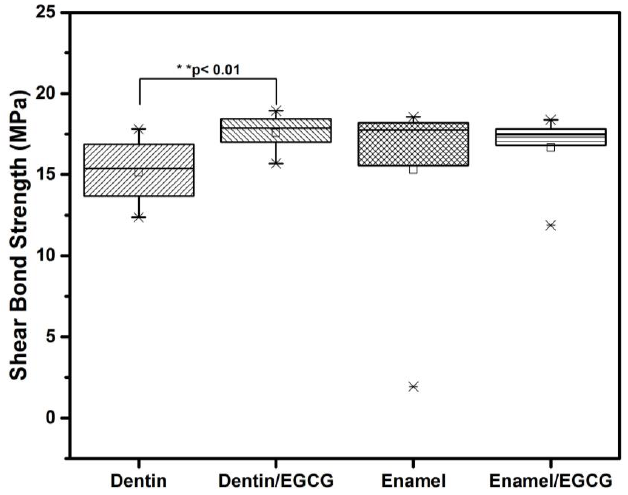
Figure 7. EGCG remineralization and shear bond strength (SBS). The enamel and dentin were demineralized with a solution containing 1.5 mM of CaCl 2 , 0.9 mM of KH 2 PO 4 , 150 mM of KCl, and 0.1 mM of sodium acetate at pH 4.5 for 360 h at 37 °C with 180 rpm. Standardized resin blocks of 4 × 4 × 1 mm adhered to enamel and dentin as follows: Group 1: dentin SBS; Group 2: dentin SBS with EGCG 3.12 µg/mL, Group 3: enamel SBS; Group 4: enamel SBS with EGCG 3.12 µg/mL. After 2 days in distilled water at 37 °C, the SBS was performed at a cross speed of 1 mm/min. Each value repre- sents the mean ± SD megapascals (MPa) of n = 10, * p < 0.05, ** p < 0.01 ANOVA post hoc Tukey test. EGCG = (-)- Epigallocatechin - Gallate ; SD = standard deviation.